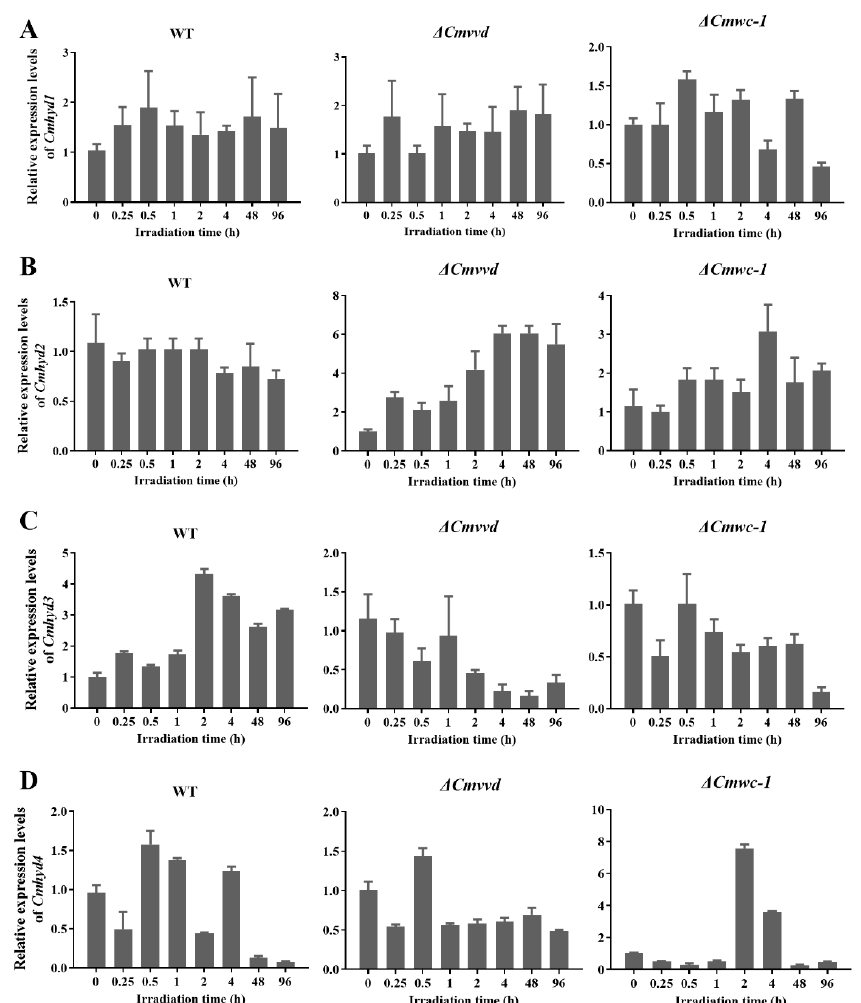
Figure 4. Transcript levels of hydrophobin genes of Cordyceps militaris after being exposed to light for different times in wild-type (WT), ∆ Cmvvd and ∆ Cmwc-1 strains. ( A ) Cmhyd1 , ( B ) Cmhyd2 , ( C ) Cmhyd3 , ( D ) Cmhyd4 . The relative expression levels at the different light exposure times were based on the standard levels of the light exposure time of 0 (under dark) in the wild-type and deletion mutants, respectively. The average ± standard deviation from three independent measurements with two technical replicates each is